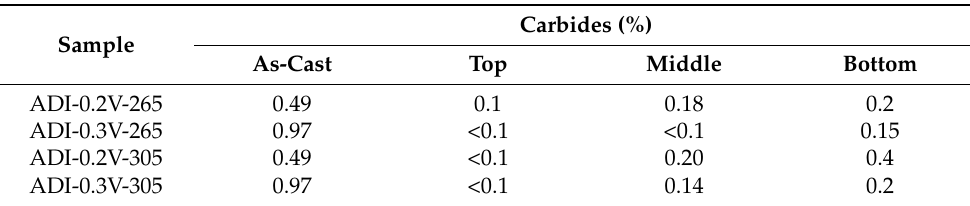
Table 5. The volume fraction of carbides for the ADIs heat-treated to 265 and 305 ◦ C to 90 min and the three regions analyzed.